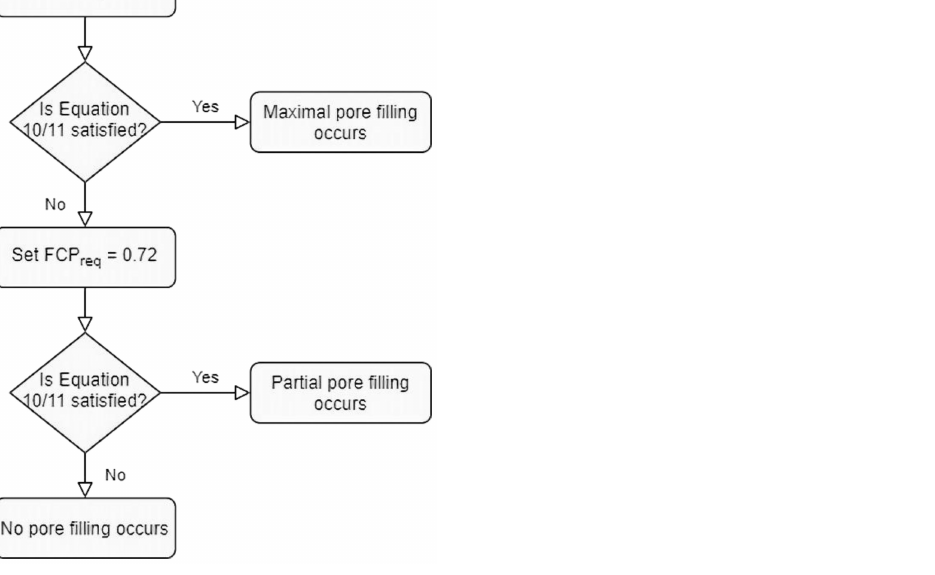
Figure 9. Flowchart detailing how the pore filling state is decided with the use of either Equation (10) or